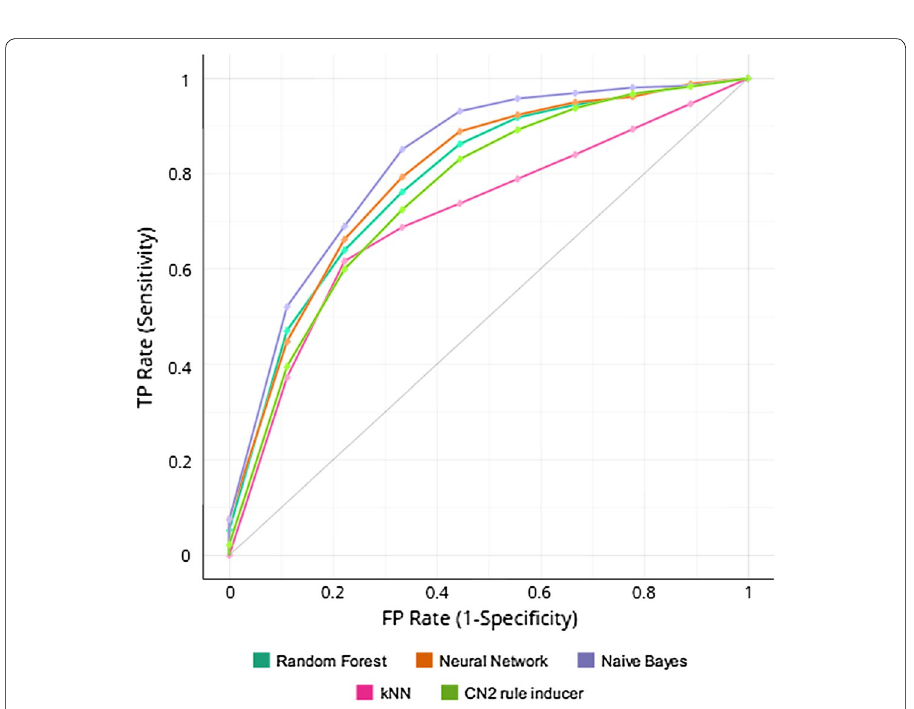
Fig. 15 ROC for the MDT IP upload